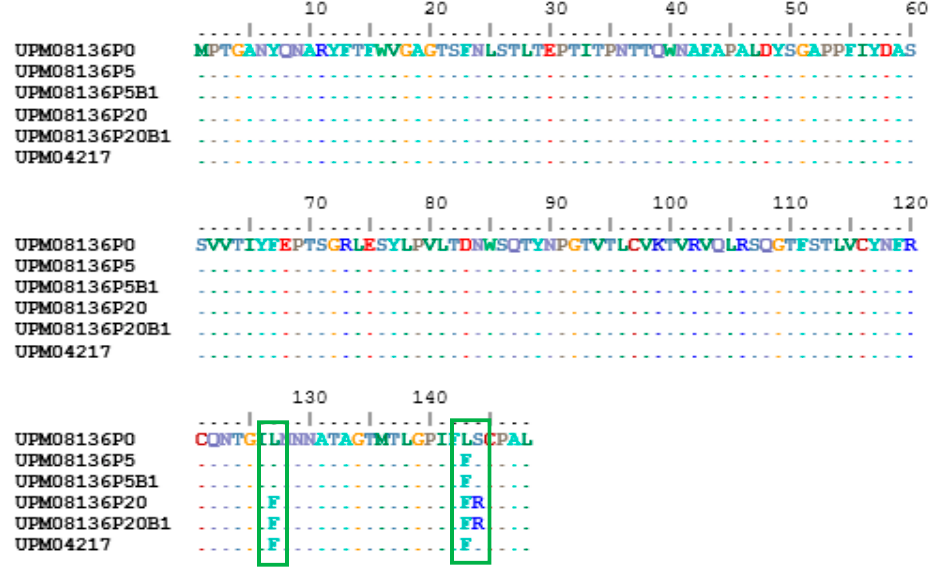
Figure 8. Multisequence alignment comparing the fiber gene amino acid residues of original, flask and bioreactor propagated isolates of UPM08136 and UPM04217 reference isolate from Genebank. There were no changes between the flask and bioreactor isolates observed in the fiber gene of the test FAdV strains. The changes in the CEL passages (green boxes) remained the same.